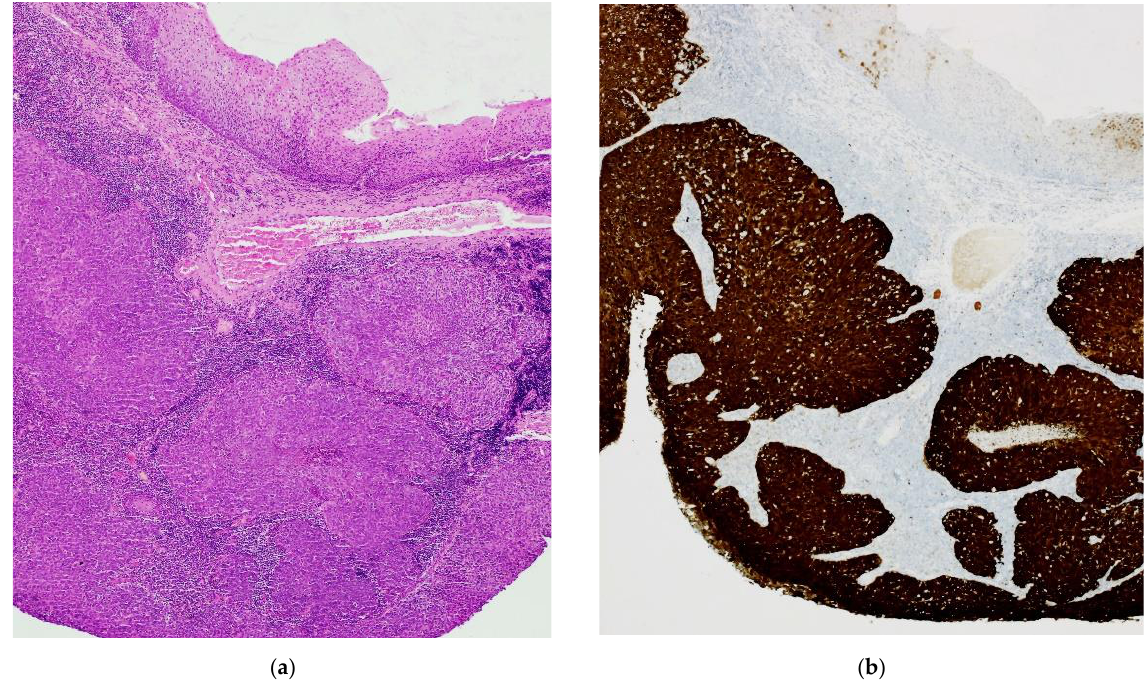
Figure 1. HPV-OPSCC: morphology and immunohistochemistry ( a ) H&E image of “basaloid” invasive squamous cell carcinoma; ( b ) Intense and diffuse positive IHC staining with anti-p16